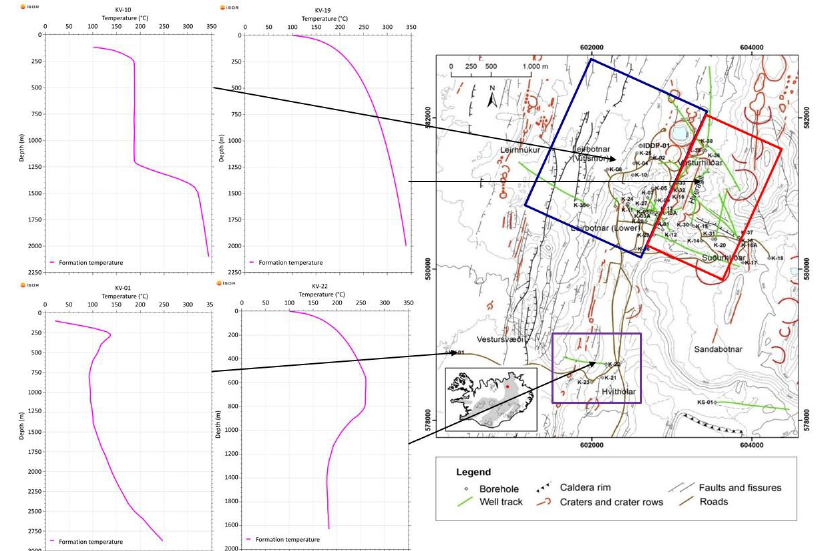
Figure 13. Drilled wells in Krafla (red dot on the little inlet map to the right) and the three main production fields (right) with different thermal character. The fields are: Vtísmór and Leribotnar (blue frame), southern and western slopes of Mt. Krafla (red frame) and Hvíthólar (purple frame). To the left are shown characteristic temperature profiles in wells in each production area and a well drilled in the fissure swarm west of Hvíthólar. For well KS-01, east of Hvíthólar, see text.